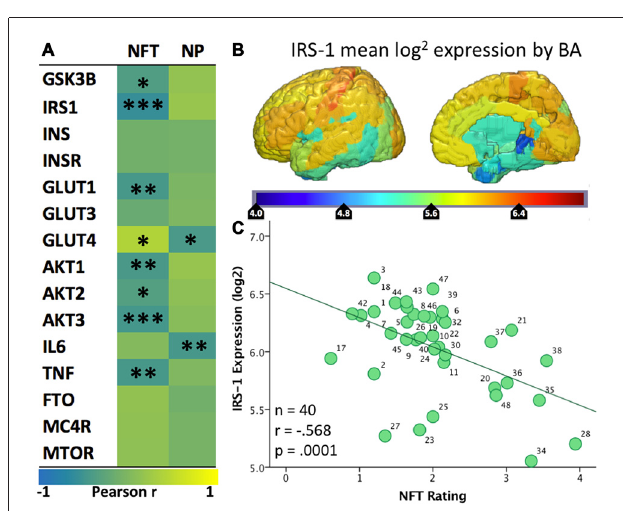
FIGURE 2 | (A) Heatmap (“jet”: red high, blue low) of the spatial correlation between levels of expression of various genes from the Allen Human Brain Atlas and the density of tangles (NFT) or plaques (NP) from Arnold et al. (1991). Asterisks ( ∗ / ∗∗ / ∗∗∗ ) represent p values of < 0.05/.01/.001, respectively. (B) Map of mean IRS-1 log2 expression in the six healthy human specimens included in the Allen Human Brain Atlas. (C) Scatter plot of the mean IRS-1 log2 expression from the Allen Human Brain Atlas and the density of tangles (NFT) from Arnold et al. (1991). Each of the 40 data points corresponds to a BA for which both gene expression levels and tangle density ratings were available.